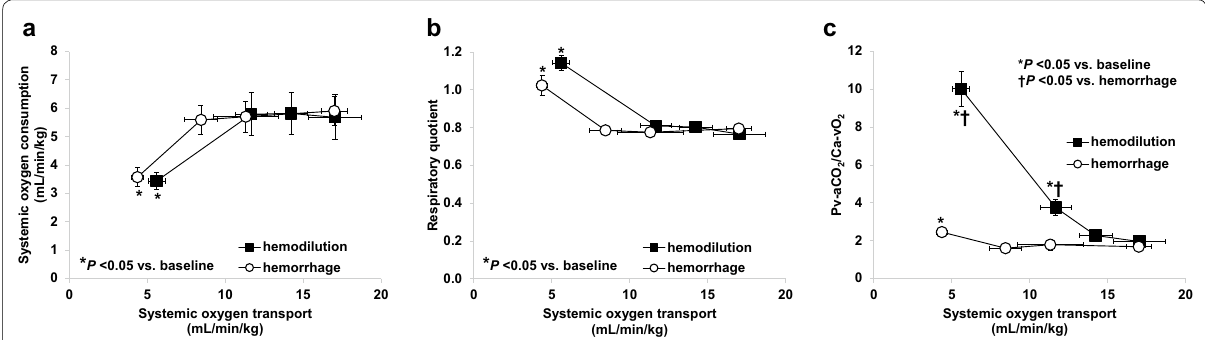
Fig. 1 Relationship between oxygen transport to oxygen consumption ( a ), respiratory quotient ( b ), and venoarterial PCO 2 difference-to-arterio- venous O 2 content difference ratio (P v–a CO 2 /C a–v O 2 ) ( c ). Oxygen consumption fell and respiratory quotient increased only in the last step of hemodi- lution and hemorrhage. In hemodilution, the increase in P v–a CO 2 /C a–v O 2 was higher than in hemorrhage and appeared before the development